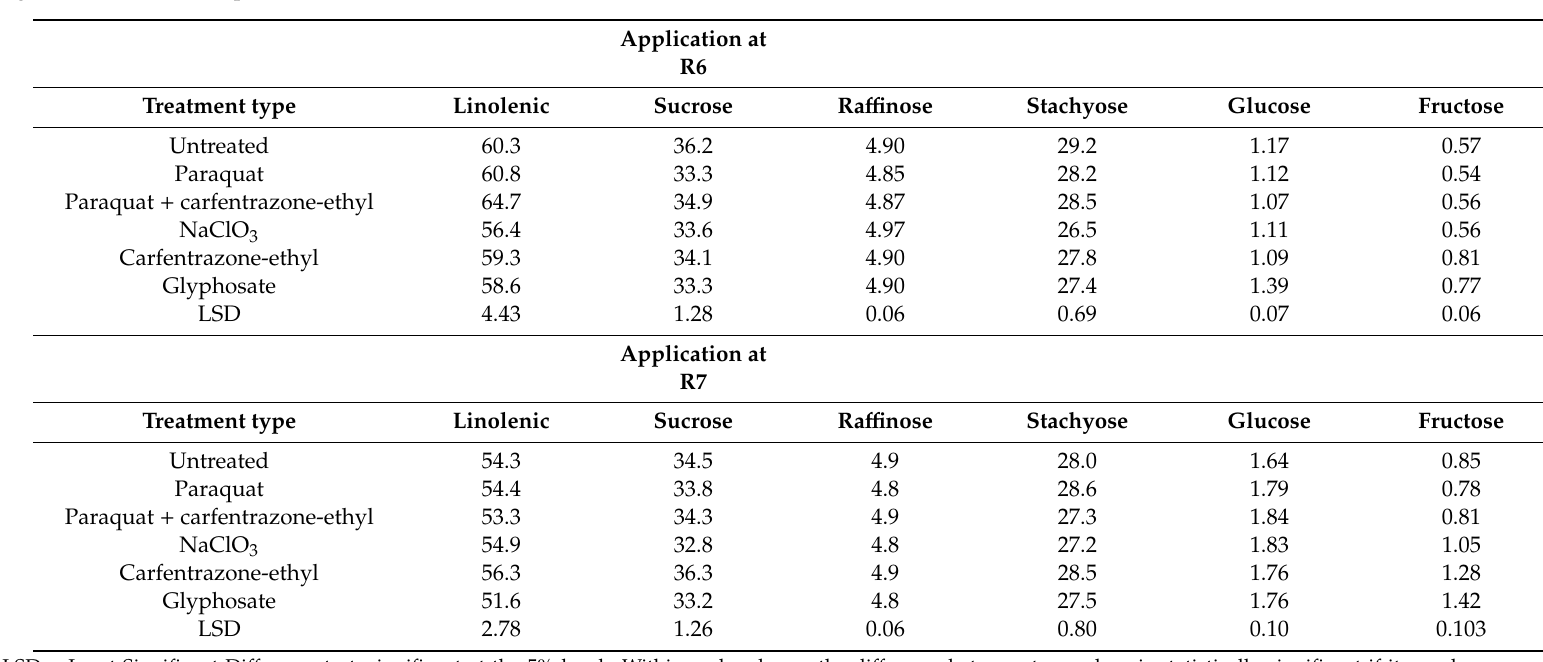
Table 4. E ff ects a of harvest aids (treatments: paraquat, paraquat + carfentrazone-ethyl, carfentrazone-ethyl, NaClO 3 , glyphosate) on seed linolenic acid (g kg − 1 ) and sugars (sucrose, ra ffi nose, stachyose, glucose, and fructose: mg g − 1 ) across two years. Untreated plants were used as the control. Harvest aids were applied at growth stages R6 and R7. The experiment was conducted in 2012 and 2013 in Stoneville,